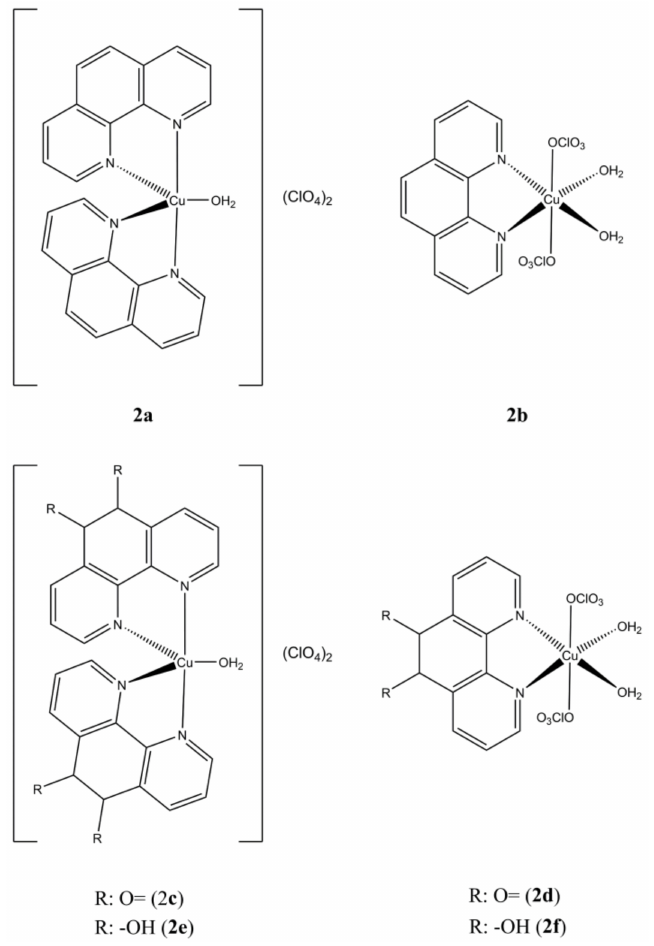
Figure 2. Structures of the Cu(N-N 1 ) x (OH 2 ) y (ClO 4 ) z